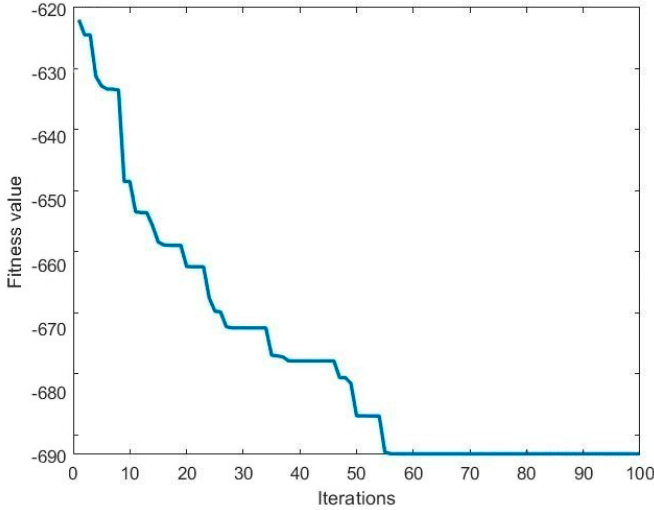
Figure 16. Convergence